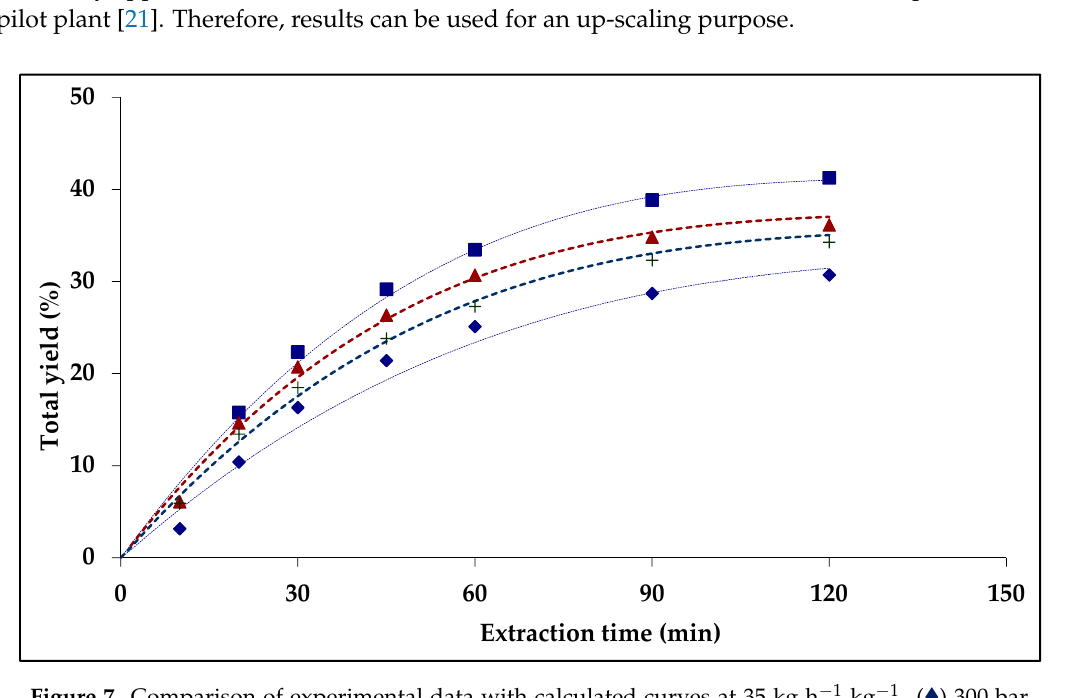
Table 2. Parameters fitted for SFE of palm mesocarp with the VTII model.